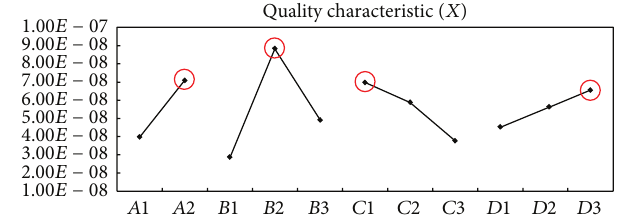
Figure 3: The factor effects response plot in 𝑋 -direction.